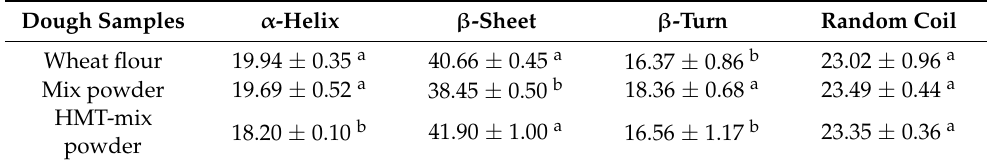
Table 5. Secondary structure content of gluten from dough of wheat flour, mix powder and HMT- mix